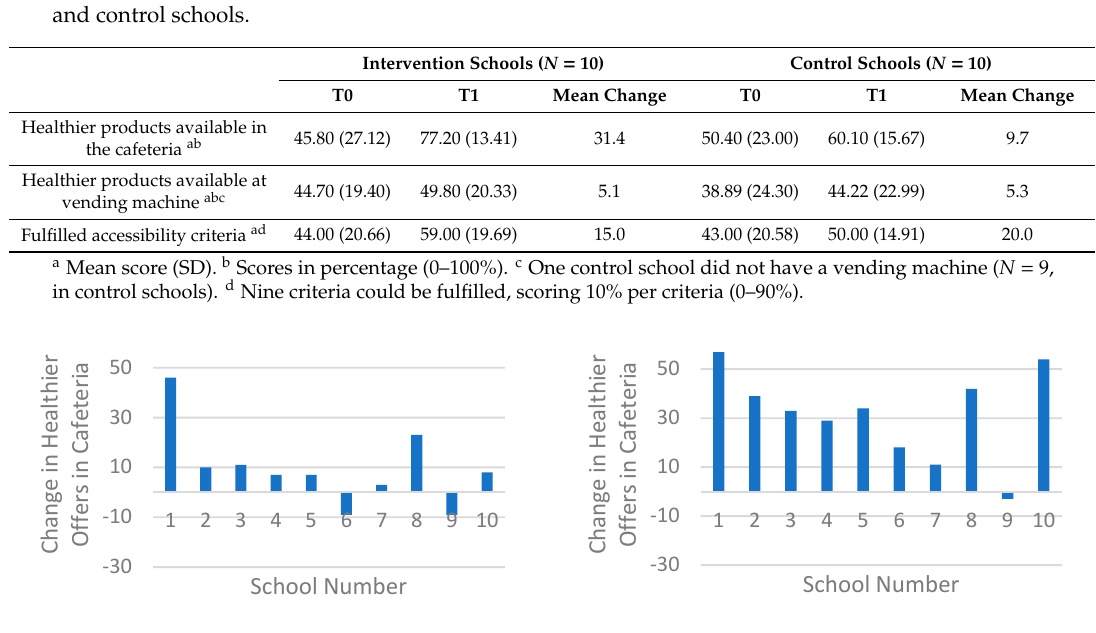
Table 2. Subscores of a healthier canteen pre- and post-intervention, stratified by intervention and control schools.